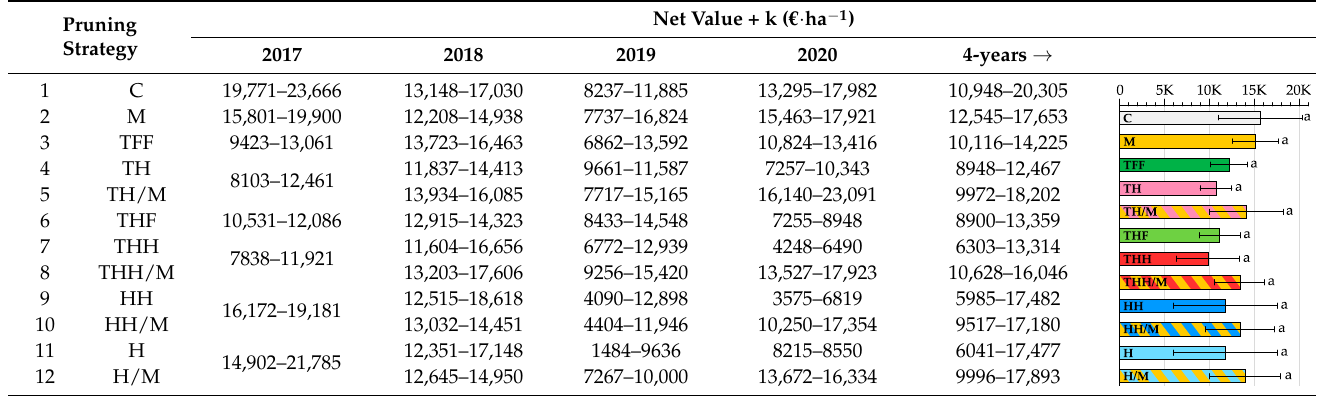
Table 9. Net value + k ( € · ha − 1 ) for each pruning strategy, for each year and for the four years overall. Data are expressed as 95% confidence interval. The graphic represents the data for the 4-year overall (average value with 95% confidence interval bar). Different letters indicate significant differences between pruning strategies (LSD test, p <